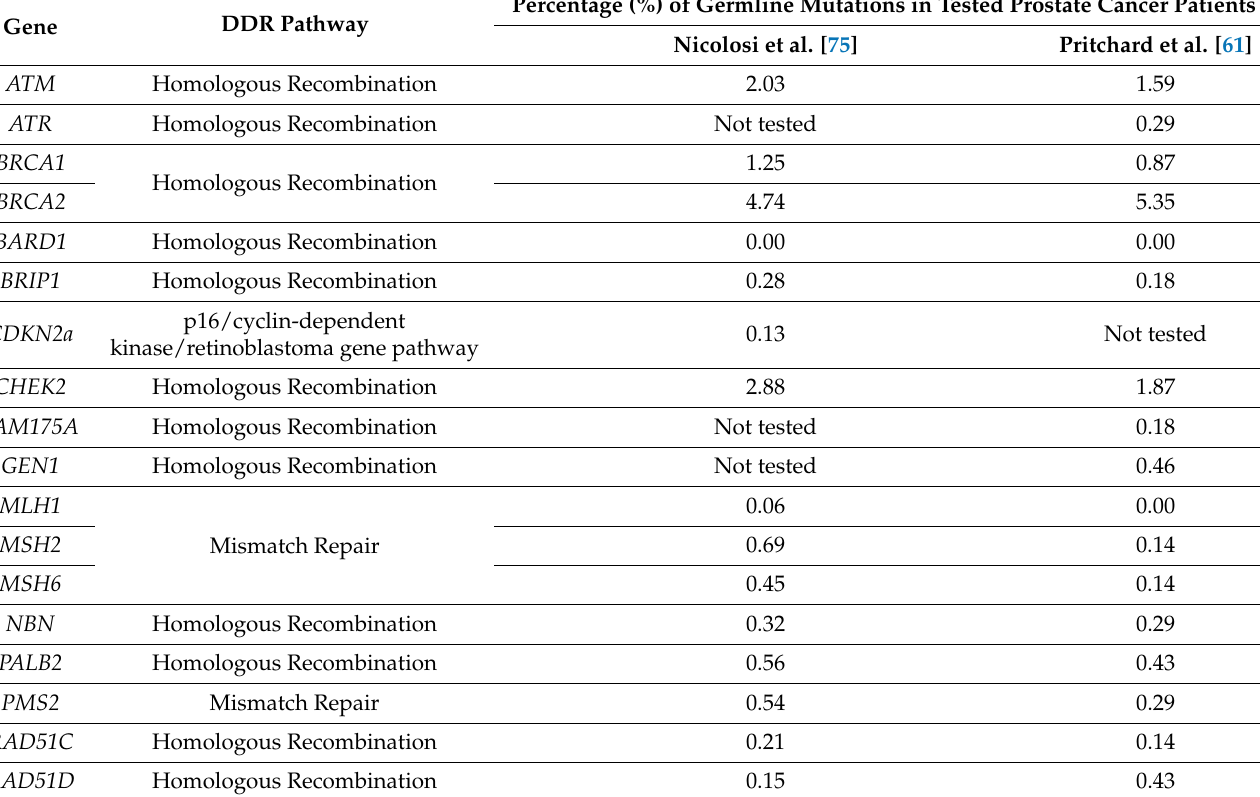
Table 1. Comparison of the percentage of germline DNA damage response mutations in prostate cancer. Percentage (%) of Germline Mutations in Tested Prostate Cancer Patients Gene DDR Pathway Nicolosi et al. [75] Pritchard et al.